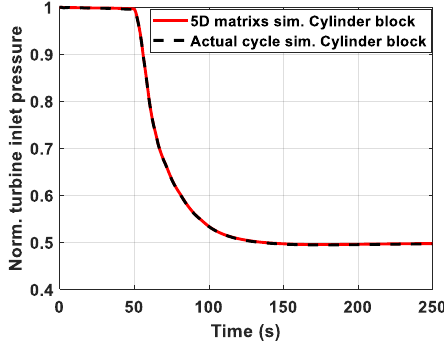
Figure 25. Compressor air flow rate time history.